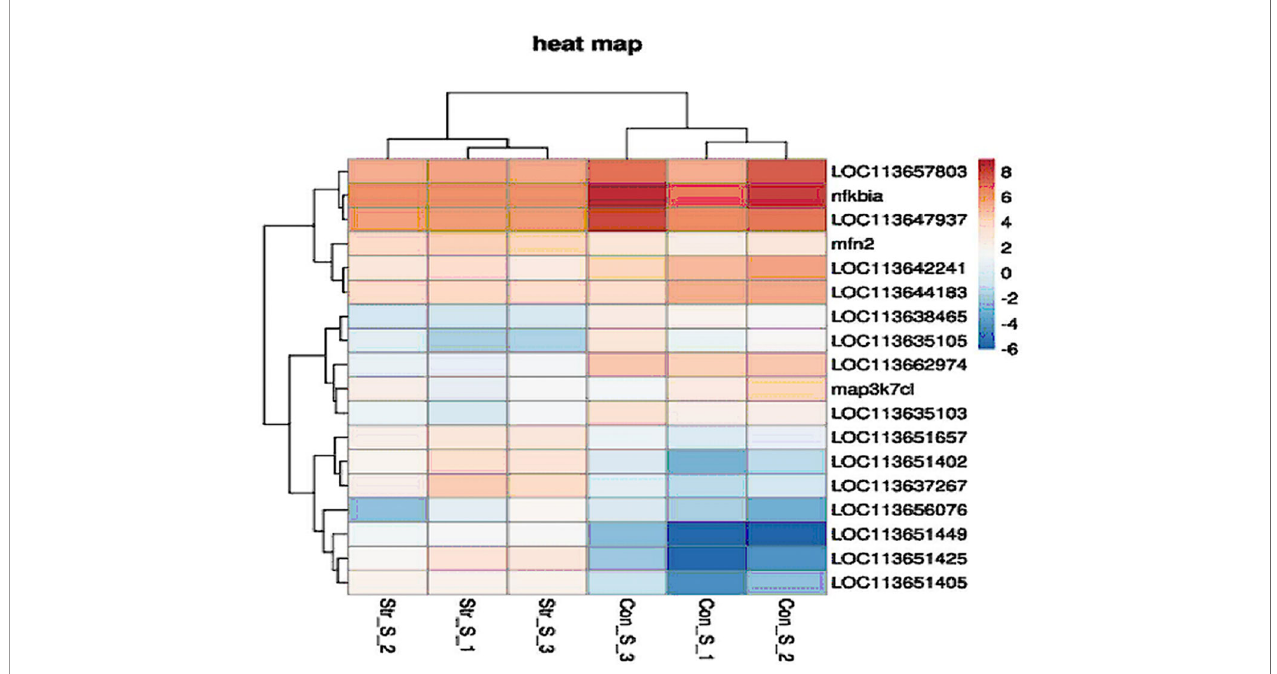
FIGURE 8 | Heat map of 20 selected differentially expressed genes (DEGs) in TLRs/NLRs signaling pathway in skin of hybrid yellow cat fi sh under transport stress (criteria for identi fi cation of DEGs: log2 FC > 1 or < -1 and P < 0.05). Highly expressed genes are shown in red; genes expressed at low levels are shown in dark